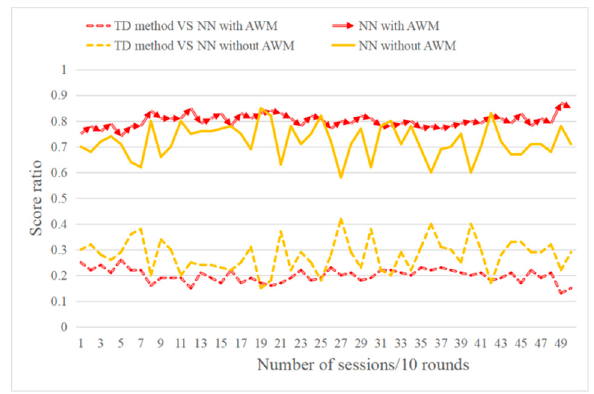
Table 2. Experimental parameters. Parameter